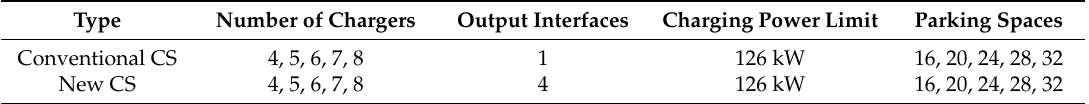
Table 3. CS parameters. Table 3. CS